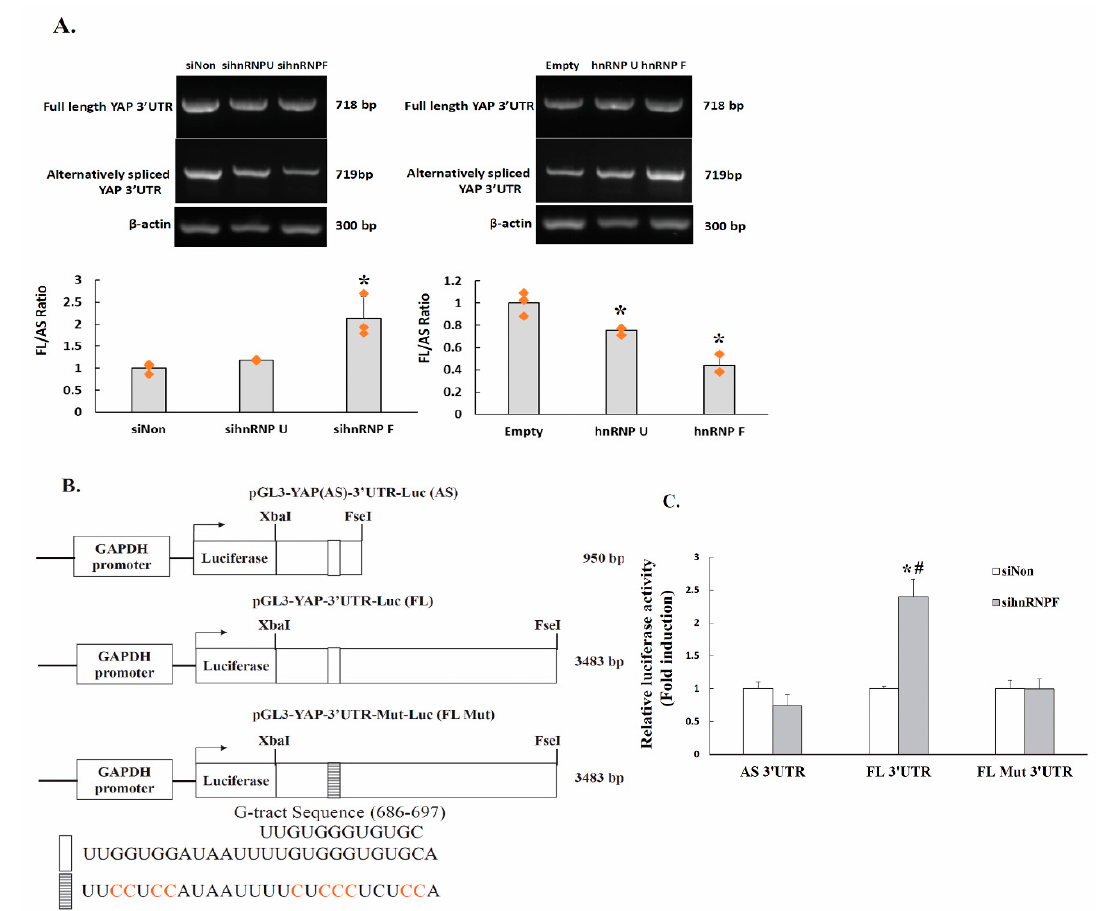
Figure 5. HnRNP F induces YAP 3 (cid:48) UTR splicing and the effect of hnRNP F on YAP 3 (cid:48) UTR-mediated mRNA stability is alternative splicing dependent. ( A ). PC-3 cells were transfected with siNon, sihnRNPU, sihnRNPF (40 nM each) (left panel), or were transfected with empty vector, pFRT-TO-HIS-FLAG-HA-hnRNPU or p3X-FLAG-hnRNPF at 0.5 µ g/mL (right panel). Twenty-four h after incubation, total RNA was isolated and the semi-quantitative RT-PCR assay was performed ( n = 3). PCR fragments were amplified by RT-PCR using primers as described in the Figure 1C, to specifically amplify the full-length YAP 3 (cid:48) UTR and alternatively spliced YAP 3 (cid:48) UTR. β -actin gene was used as an internal control for RNA quality and loading. Significance was tested using one-way analysis of variance (ANOVA) with Holm–Sidak method post hoc test, where * p < 0.05 compared to the control. ( B ). Schematic diagram of the luciferase reporter used in assay. Another G-tract located in full-length YAP 3 (cid:48) UTR at 3219 to 3230 was not shown in this diagram. ( C ). PC-3 cells were transfected with 0.5 µ g of pGL3-YAP(AS)-3 (cid:48) UTR-Luc, pGL3-YAP-3 (cid:48) UTR-Luc or pGL3-YAP-3 (cid:48) UTR-Mut-Luc along with 40 nM siRNA against non-silencing control (siNon) or hnRNP F (sihnRNPF) for 24 h ( n = 3). The cells were also cotransfected with a pSV- β -galactosidase vector, and the β -galactosidase activity was used to normalize the luciferase activity. Luciferase activity is presented as the fold induction relative to the control. Data are means ± s.d from triplicate analysis. Significance is tested using ONE-WAY ANOVA with Holm-Sidak method post hoc test, where * denotes p < 0.05 compared to the siNon transfected cells; where # denotes p < 0.05 compared to the cells cotransfected with pGL3-YAP(AS)-3 (cid:48) UTR-Luc and same